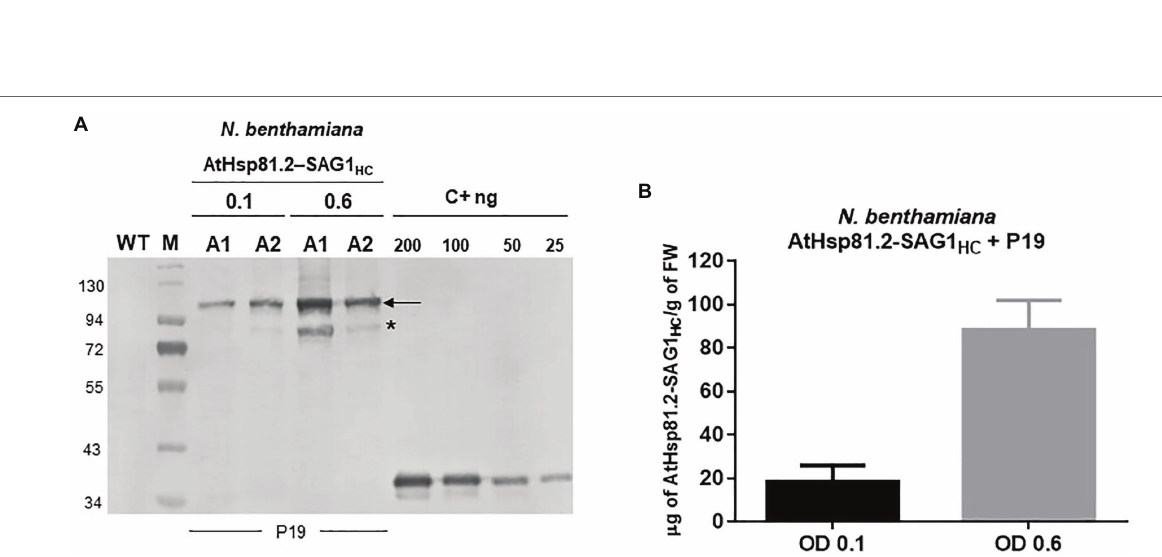
FIGURE 2 | and AtHsp81.2–SAG1 HC and grown under fluorescent or LED lights. Serial dilutions of rEcSAG1 m were used as a reference for protein quantification. Lanes were loaded with an equal amount (50 μ g) of total proteins for direct comparison. WT, agroinfiltrated with A. tumefaciens containing an empty expression vector;